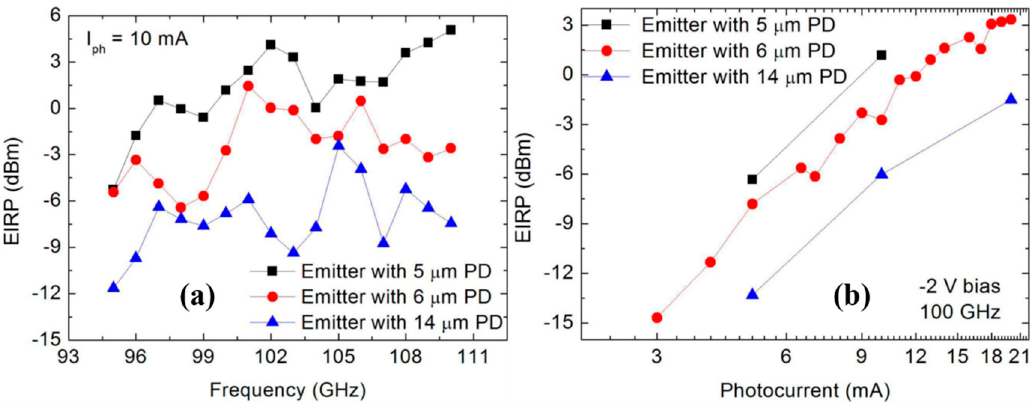
Figure 10. ( a ) Effective isotropic radiated power (EIRP) of the integrated photonic emitters with 5-, 6-, and 14-µm-diameter PDs at 10-mA photocurrent from 95 to 110 GHz. ( b ) EIRP at 100 GHz as a function of average photocurrent.